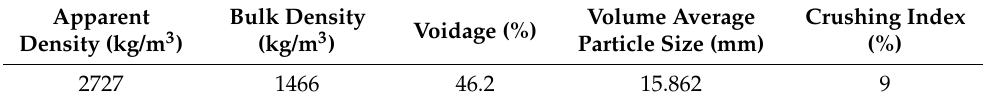
Table 5. Main technical properties of crushed stone.